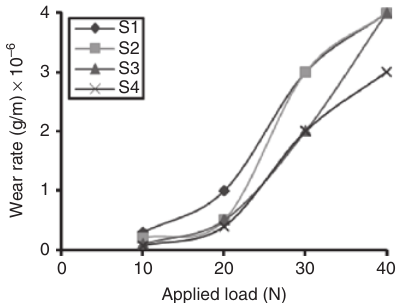
Figure 5: The effect of the applied load on the adhesive wear rate of the investigated